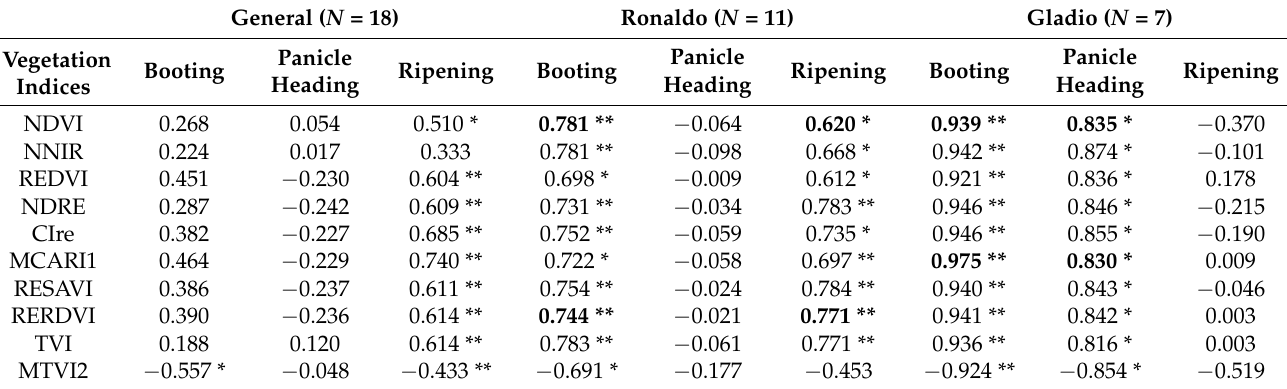
** Correlation is significant at the 0.01 level (two-tailed), * Correlation is significant at the 0.05 level